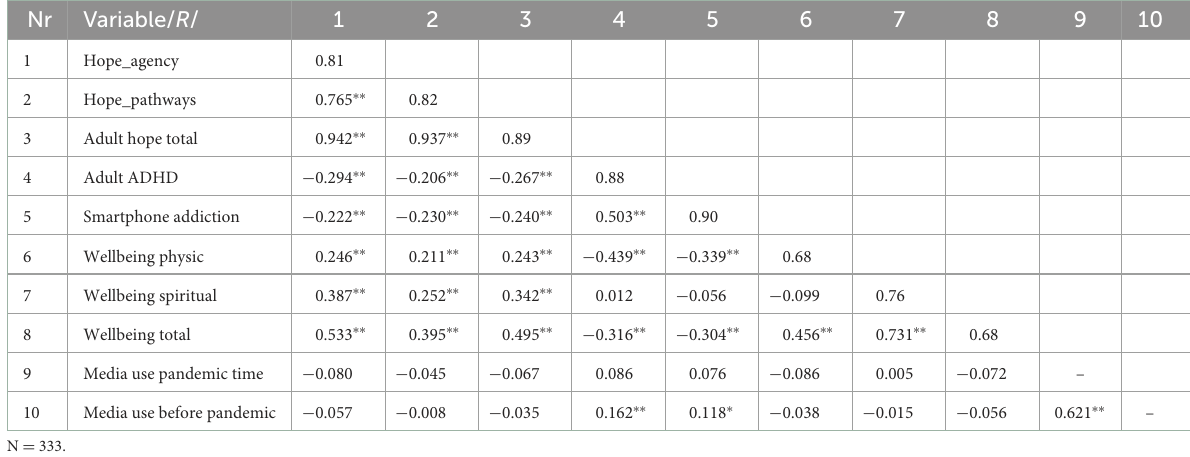
TABLE 3 Correlation matrix and results of reliability analysis.